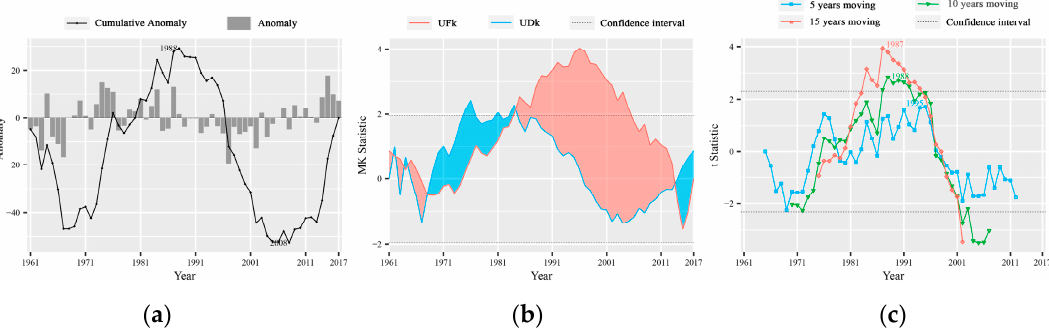
Figure 5. The abrupt change point identification diagram of autumn ET 0 sequence, where the picture category of the ( a – c ) is same to Figure 2.